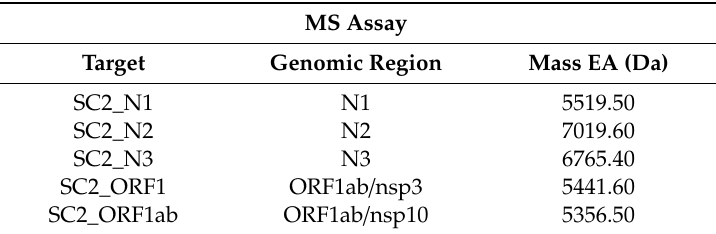
Table 1. Targets of the MS assays. MS